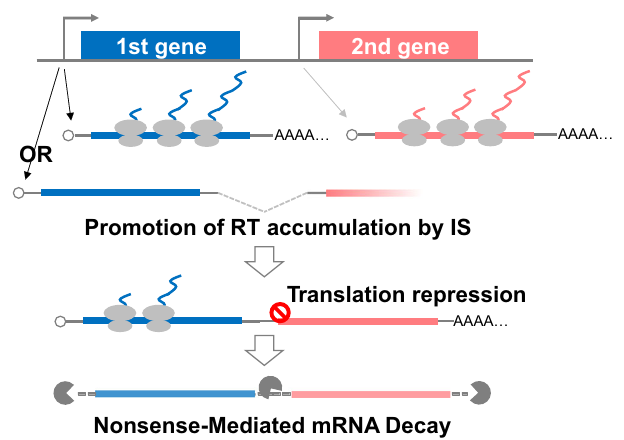
Fig. 6 Model for suppression of IS-stimulated readthrough transcription by NMD. IS events prevent transcription termination at the 3' end of the fi rst gene and promote readthrough transcriptional elongation and accumulation of RTs. However, NMD selectively degrades them by recognizing termination codons of fi rst ORFs and downstream UTRs including second ORFs as premature termination codons and long 3'